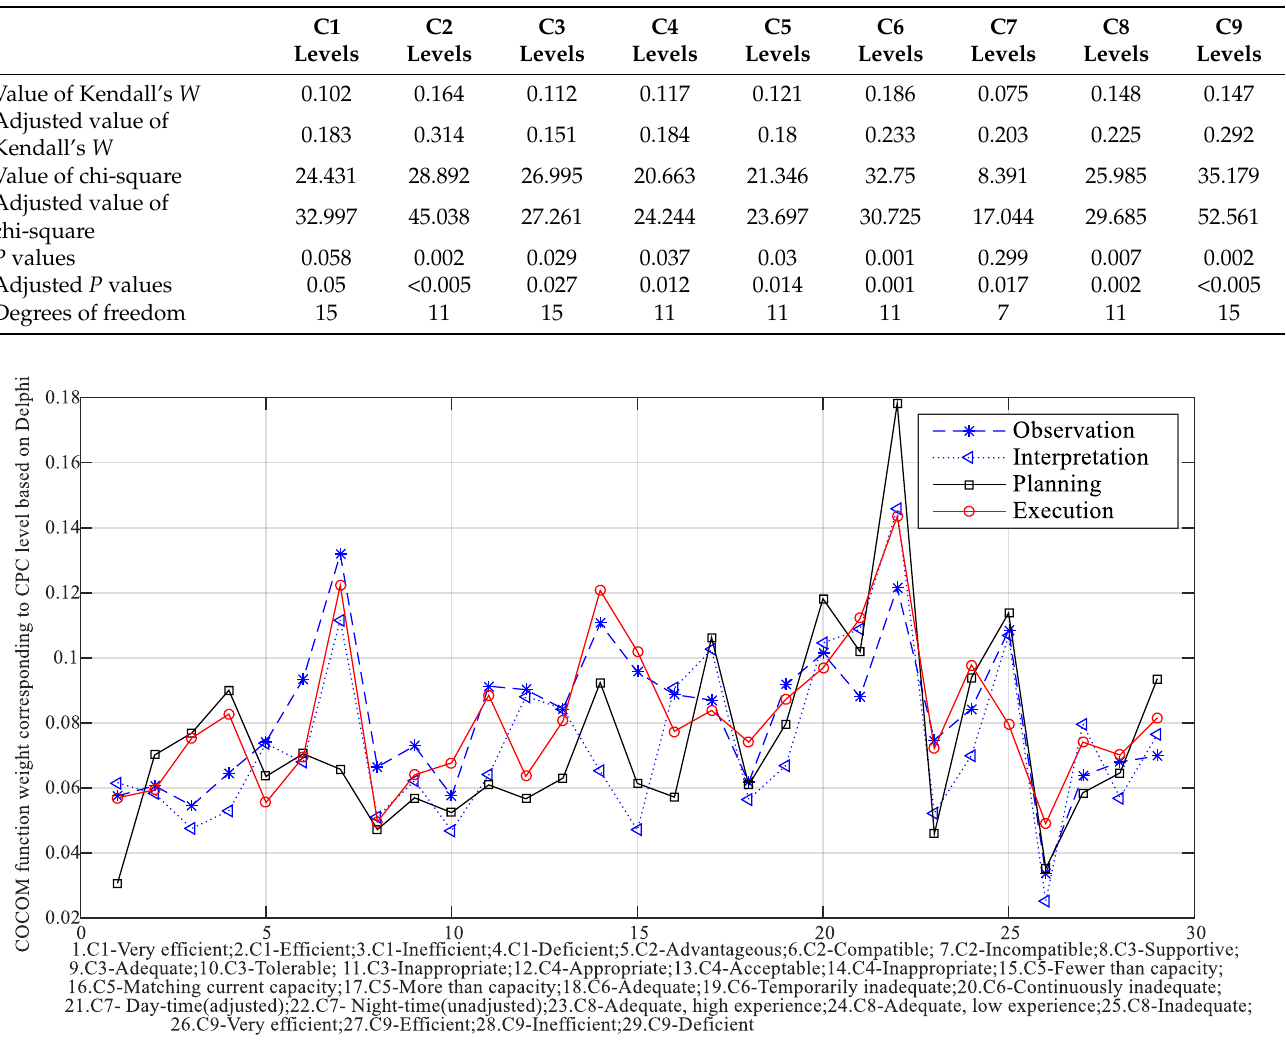
Table 1. The results of consistency tests before and after grey correlation analysis based on CPCs.